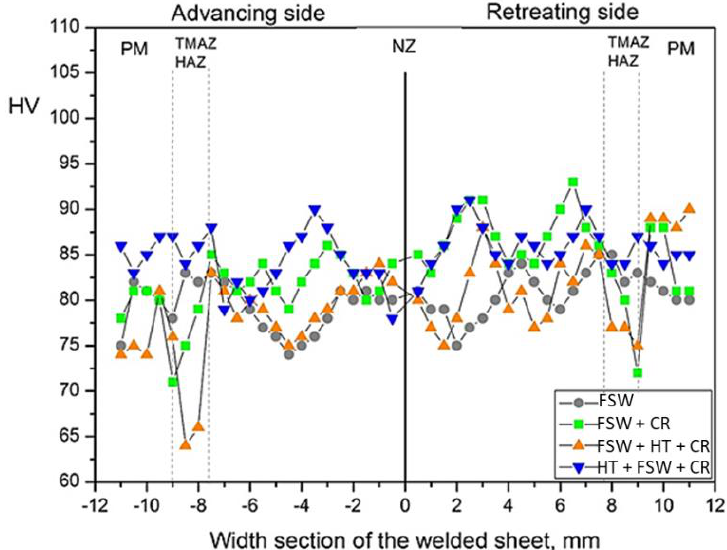
Figure 7. Microhardness profile of the welded joint, for the FSW processing conditions A.